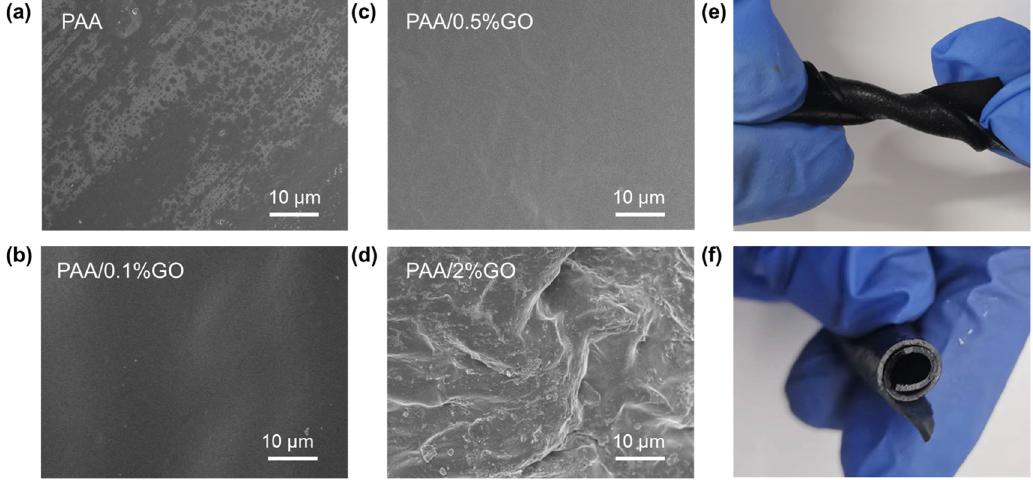
Figure 2. Scanning electron microscope (SEM) images of ( a ) PAA, ( b ) PAA/0.1%GO, ( c ) PAA/0.5%GO, and ( d ) PAA/2%GO. ( e ) Torsion properties and ( f ) rolling properties of composite PAA/0.5%GO electrolytes.